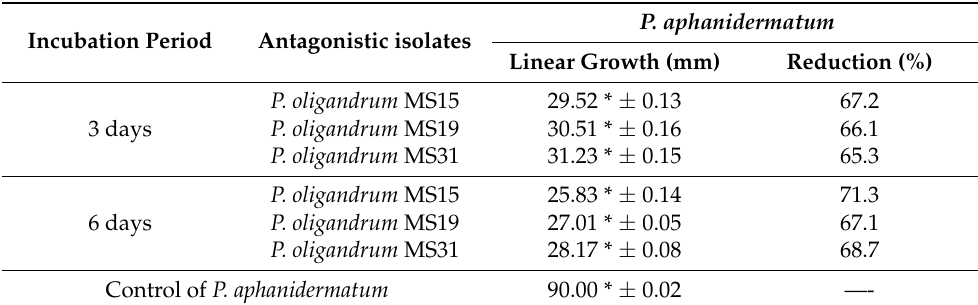
Table 1. The reduction in mycelial growth of the pathogenic P. aphanidermatum by P. oligandrum isolates (MS15, MS19 , and MS31).